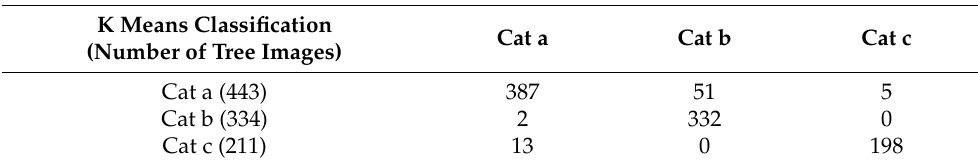
Table 7. Classification relative to ground truth categories from k-means clustering (values in brackets) for the Xception_classification model. Results are of the training set, i.e., the 2017 orchard A image set (988 images of 494 trees).